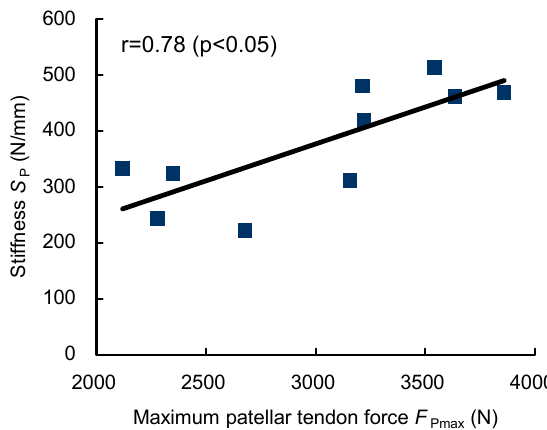
Fig. 5 Relationship between the patellar tendon stiffness and the maximum patellar tendon force.